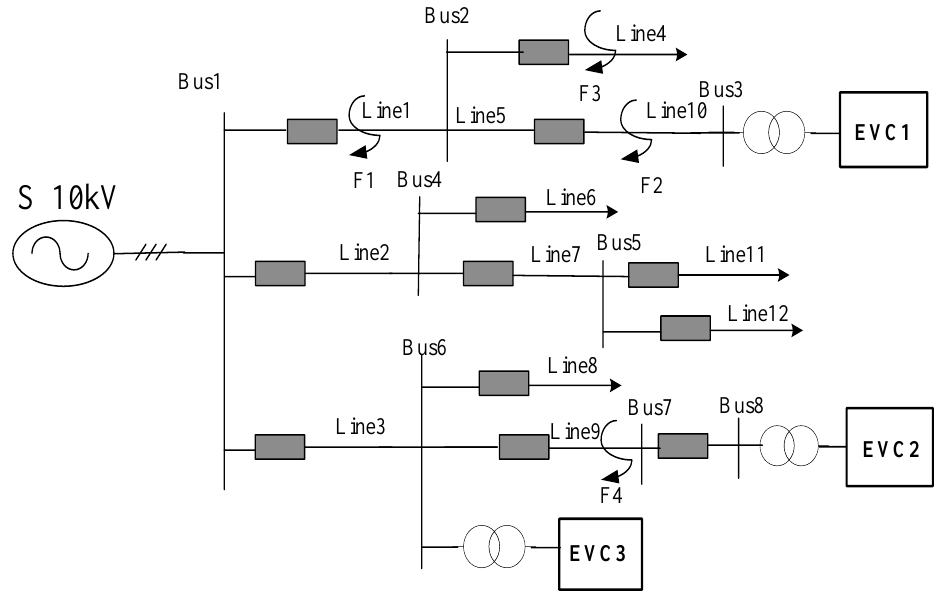
Figure 8. Charging and discharging stations are connected to 10 kV distribution network model.